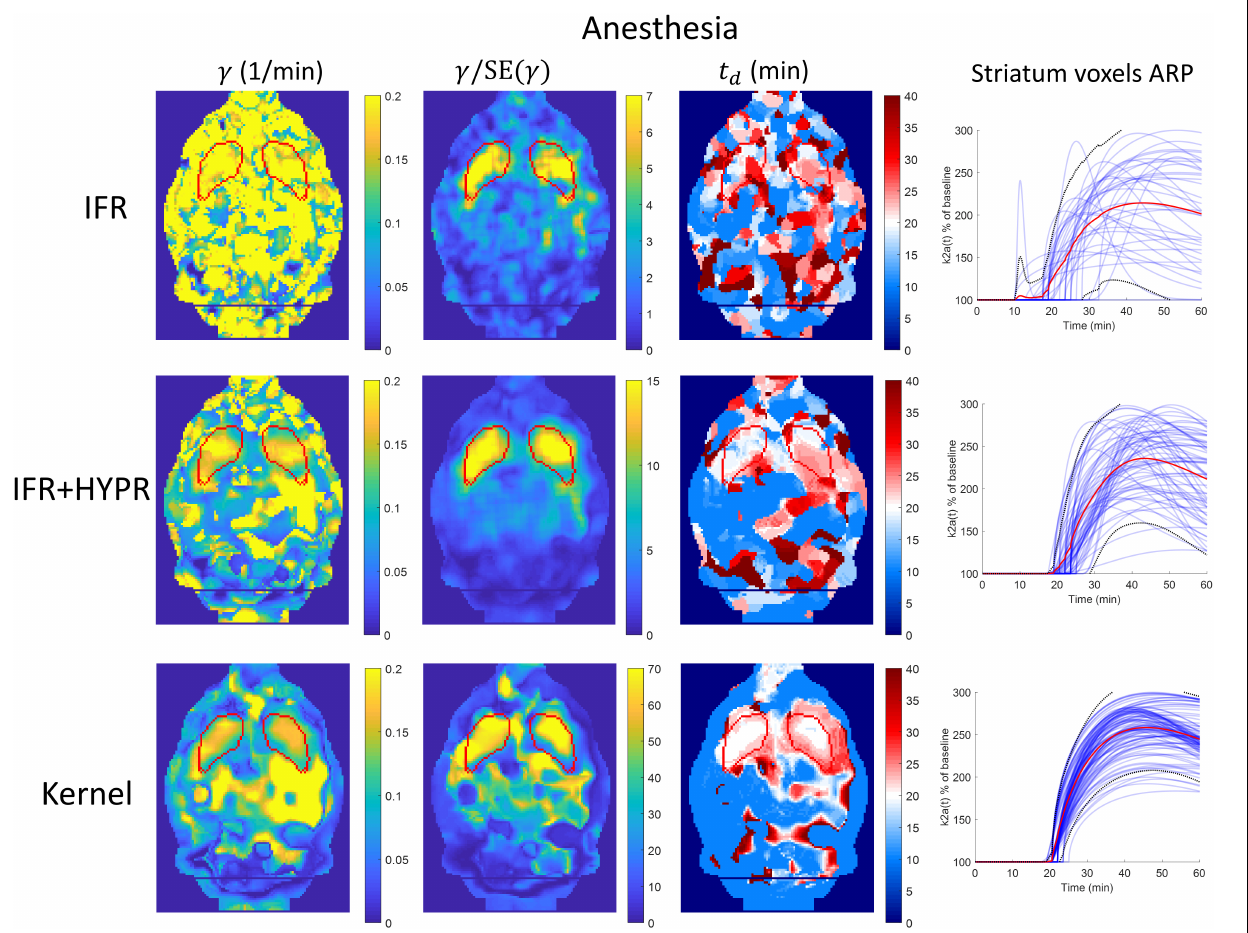
FIGURE 7 | Parametric γ , γ /SE( γ ) ( γ t-statistic), and t d brain maps, as well as activation response profiles (ARP) for striatum voxels, calculated using independent frame reconstruction (IFR, first row), independent frame reconstruction with HYPR denoising (IFR+HYPR, middle row), and spatiotemporal kernel reconstruction (Kernel, third row), for the anesthetized rat scan. White regions in t d maps correspond to cold raclopride injection time (20 min). Striatum delineated from MRI template shown in